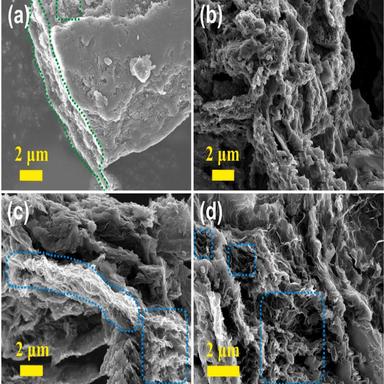
SEM images of GR (a), hp-GR-1.0 (b) and hp-NGR-1.0 (c, d).